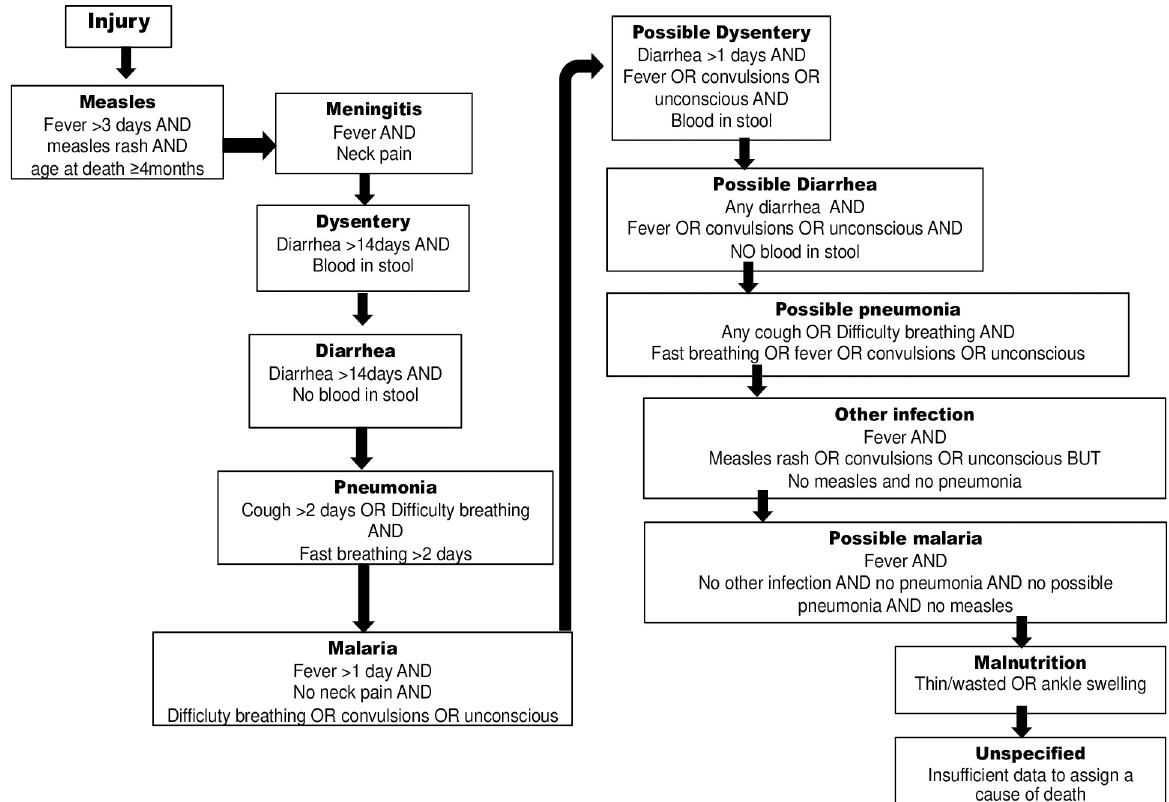
Fig 2. Causes of death as assigned using a modified verbal autopsy hierarchy